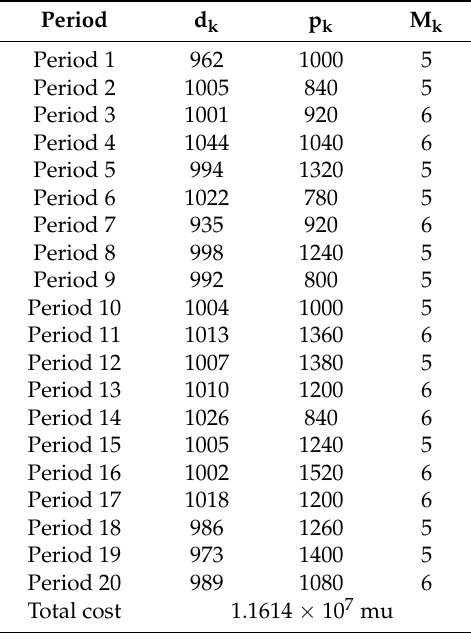
Table 3. Case 1: Production plan for group maintenance policy.